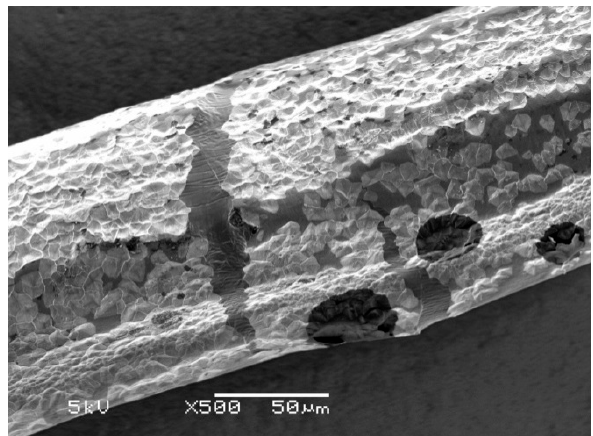
Figure 23. Evidence of healed of breeches in the oxide layer.